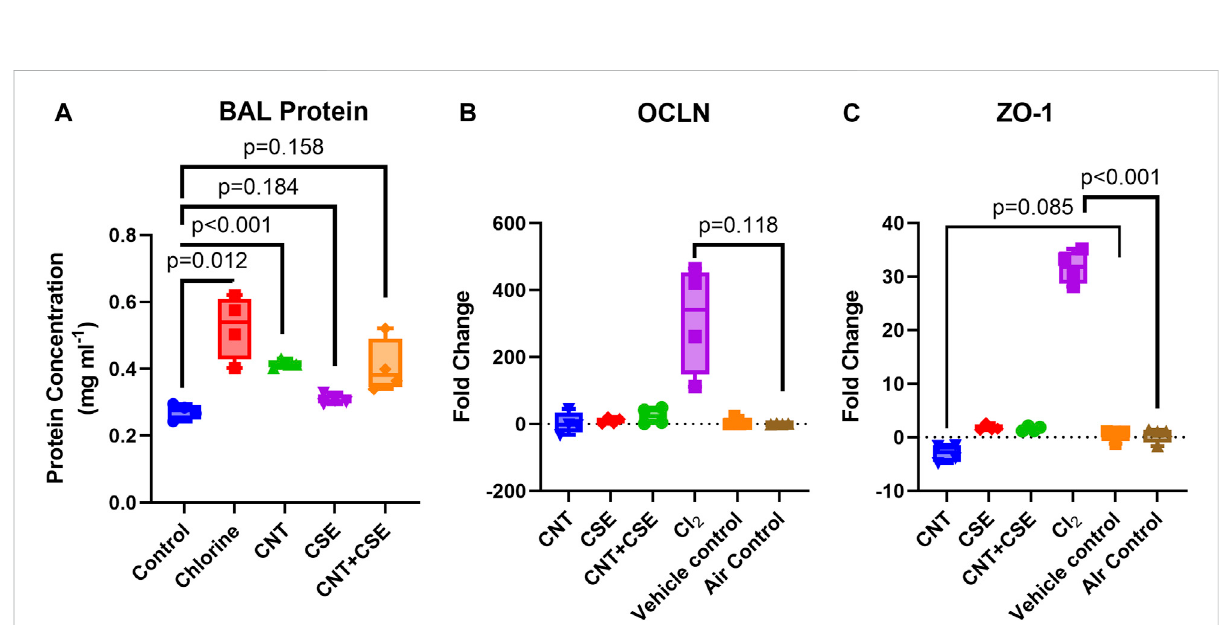
FIGURE 3 Quantitativeassessmentofcompromisedlungintegritybasedonprotein fi ltration[BALproteincontent (A) ]andexpressionofcelltightjunction proteins [OCLN (B) andZO-1 (C) ]inmicesubjectedto differentrespiratoryexposureregimensforCNT,CSE,CNT+ CSE,andCl 2 ,as described inthe Figure 1 legend. Transcriptional expression of the cell tight junction proteins occludin (OCLN) and zona-occludens-1 (ZO-1) was measured using gene-speci fi c qRT-PCR. Statistical differences are represented by p